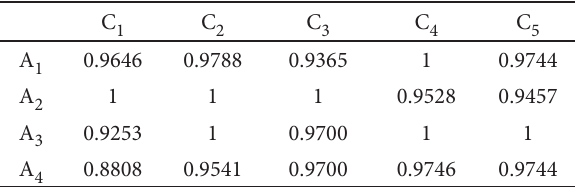
Table 7. WASPAS weighted and normalized decision making matrix for multiplication part